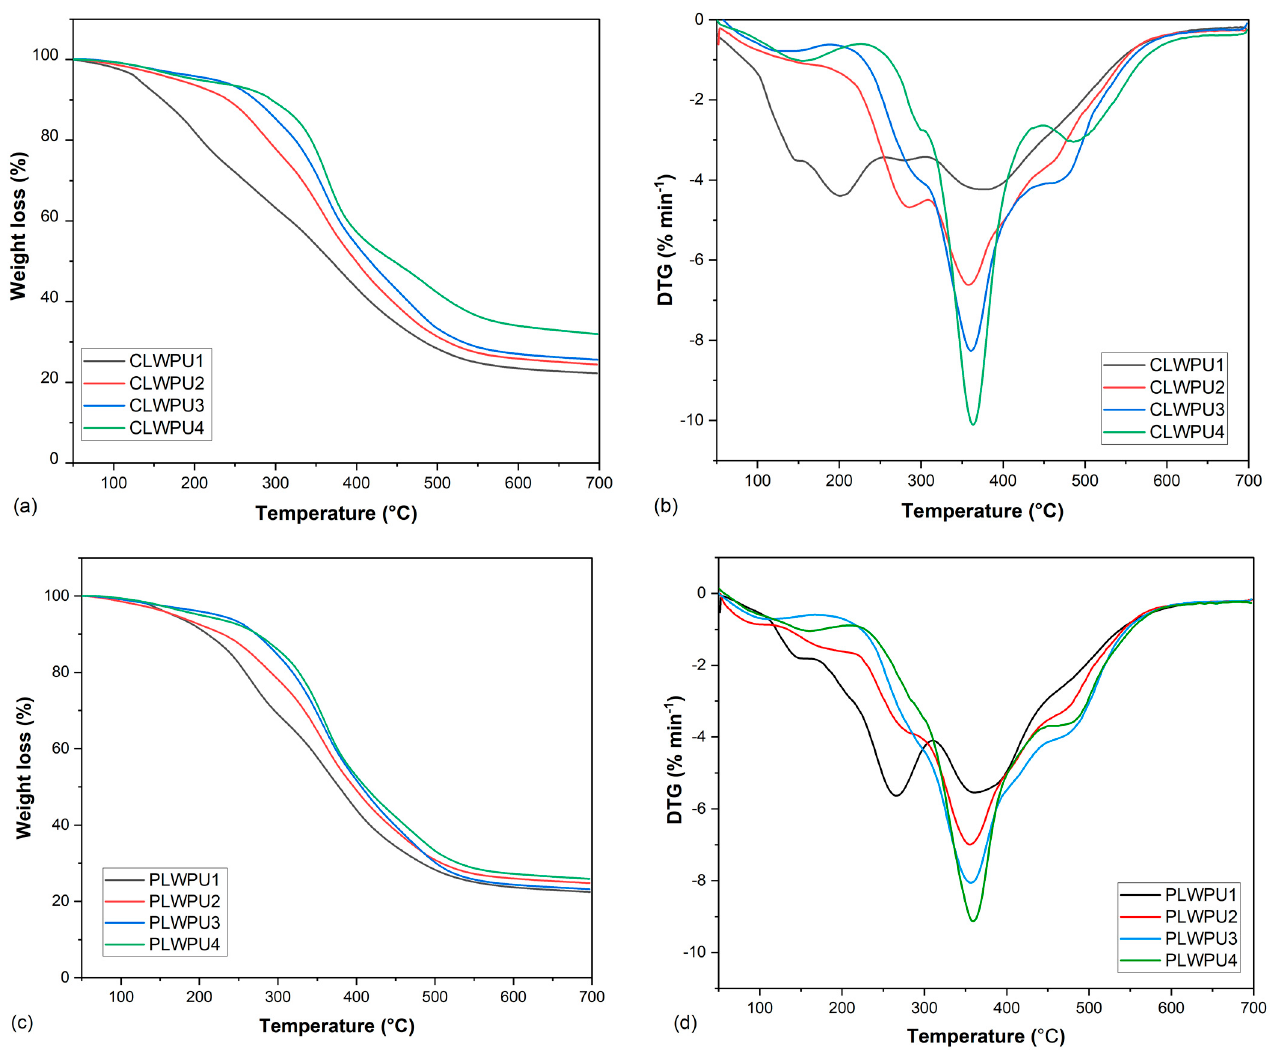
Figure 8. Mass loss of CLWPU1 − 4 ( a ) and PLWPU1 − 4 ( c ); first derivative of CLWPU1 − 4 ( b ) and PLWPU1 − 4 ( d ). Table 5. Thermal degradation stability of cured CLWPU and PLWPU adhesives.